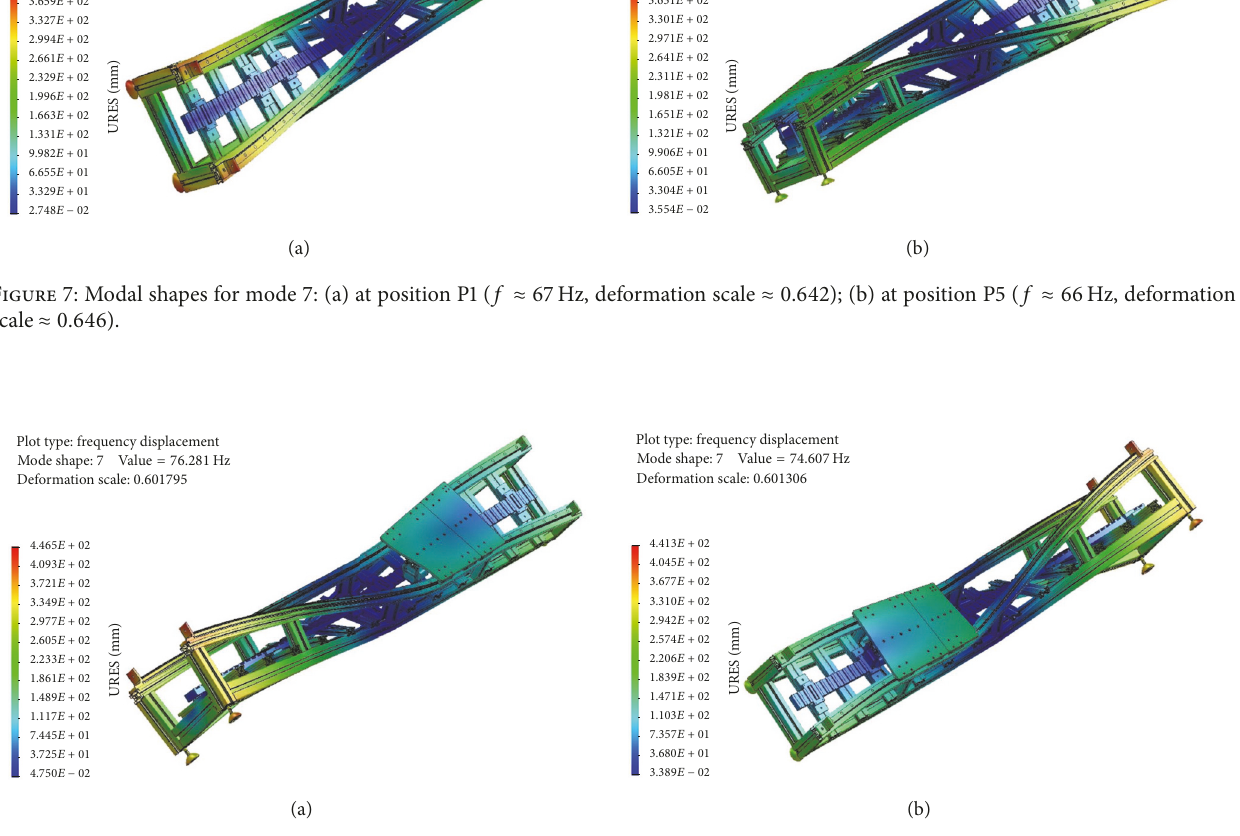
Figure 8: Modal shapes for mode 7: (a) at position P2 ( 𝑓 ≈ 76 Hz, deformation scale ≈ 0.602); (b) at position P4 ( 𝑓 ≈ 75 Hz, deformation scale ≈ 0.602).